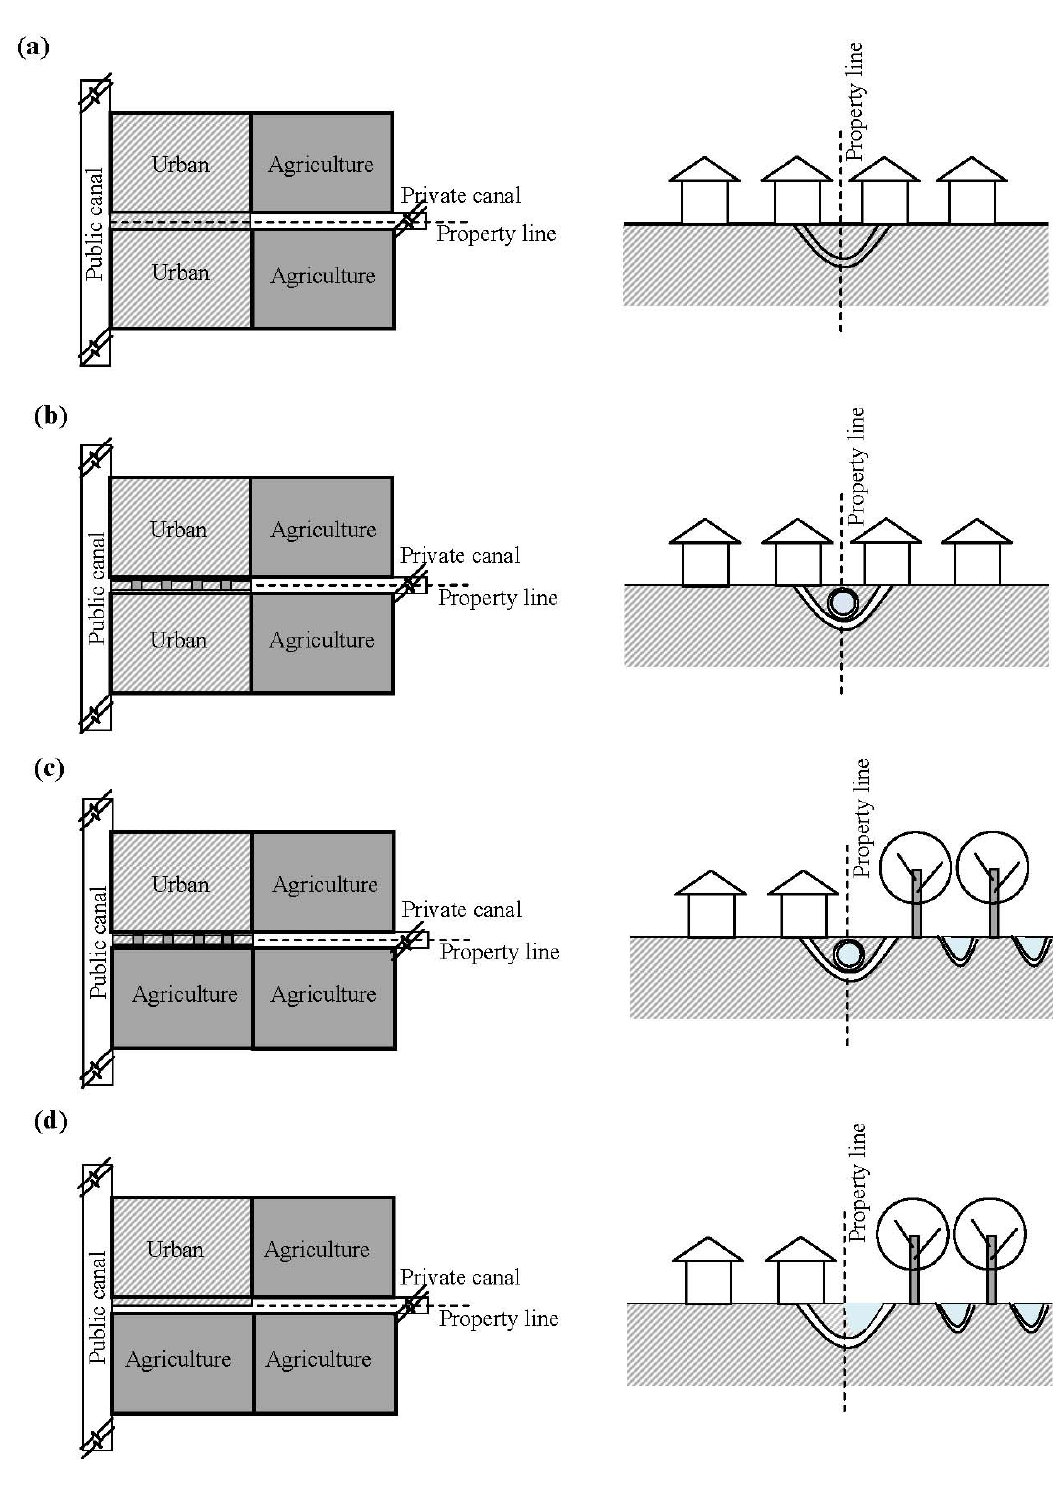
Figure 9. Typology of land configurations in relationship to deterioration of private canals ( a ) Filled-Urban-Urban; ( b ) Covered-Urban-Urban; ( c ) Covered-Urban-Agriculture; ( d ) Narrowed and